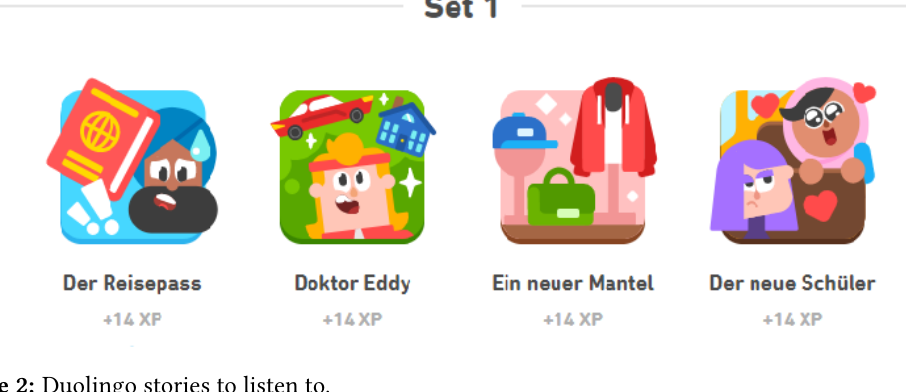
Figure 2: Duolingo stories to listen to.